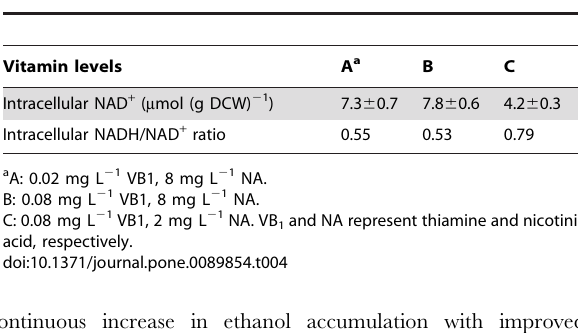
Table 3. Results of fermentation carried out using strain DA-3 with different concentrations of metal ions and vitamins.